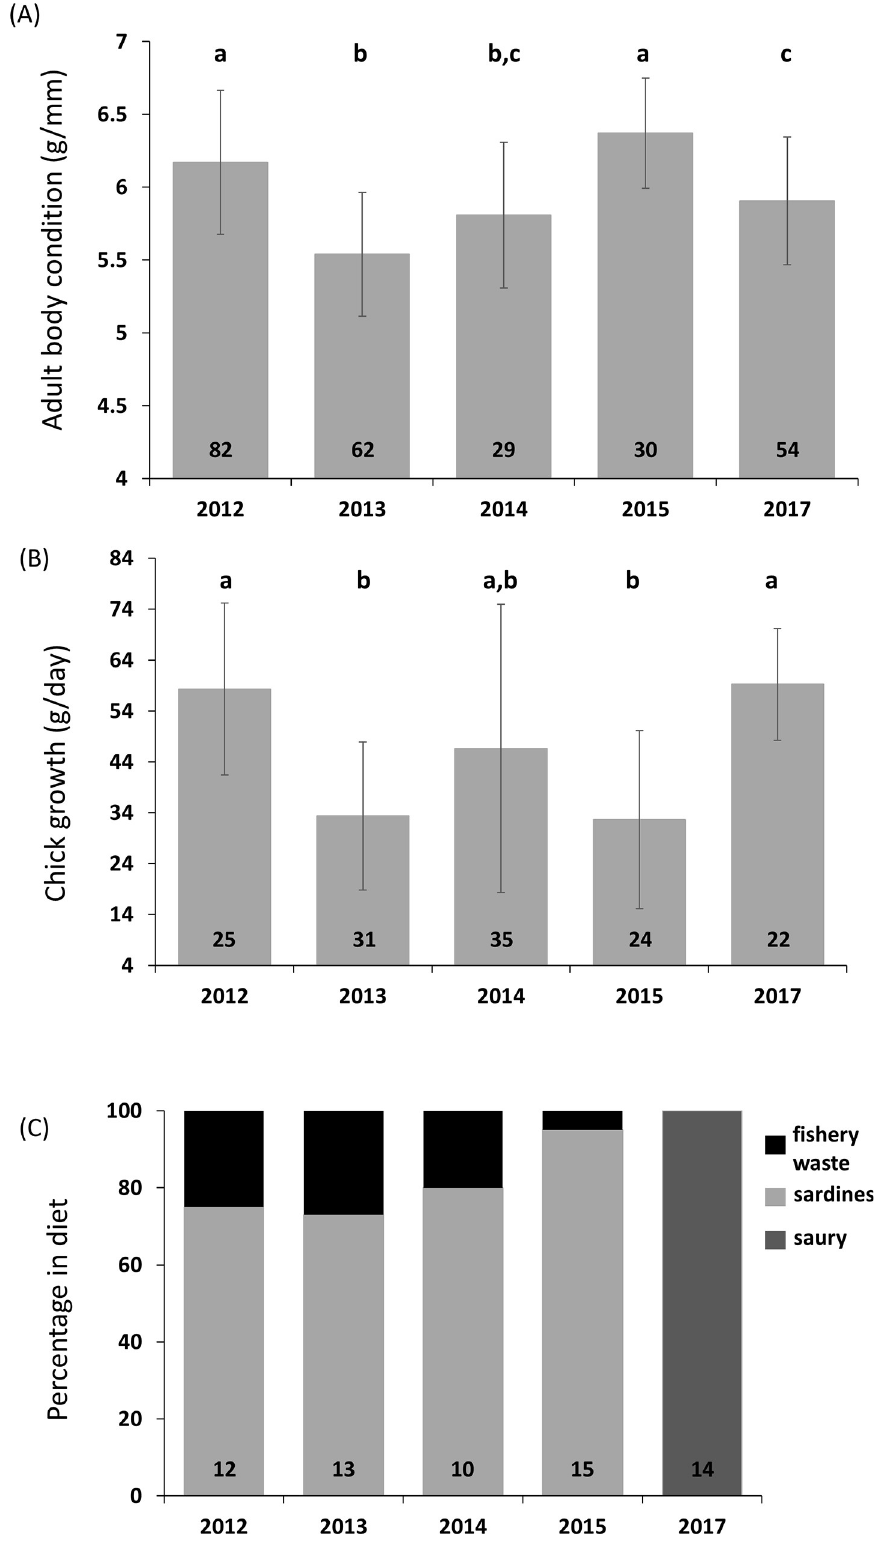
Fig 2. Cape gannet adult body condition index (bars: upper graph) and chick growth rates (bars: Middle graph), as well as Cape gannet diet (bars: Lower graph) for the 2012–2015 and 2017 breeding seasons on Malgas Island. Numbers at the bottom of histogram bars show sample sizes, and different letters above histogram bars denote statistically significant differences among years.